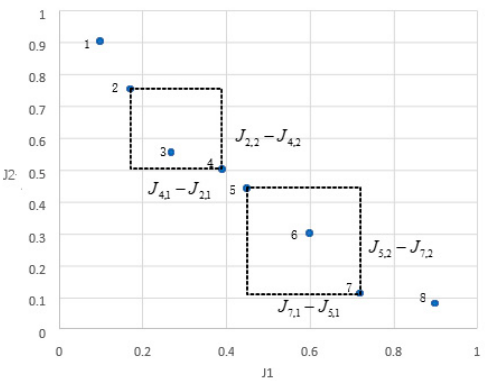
Figure 7. Density function between individuals.